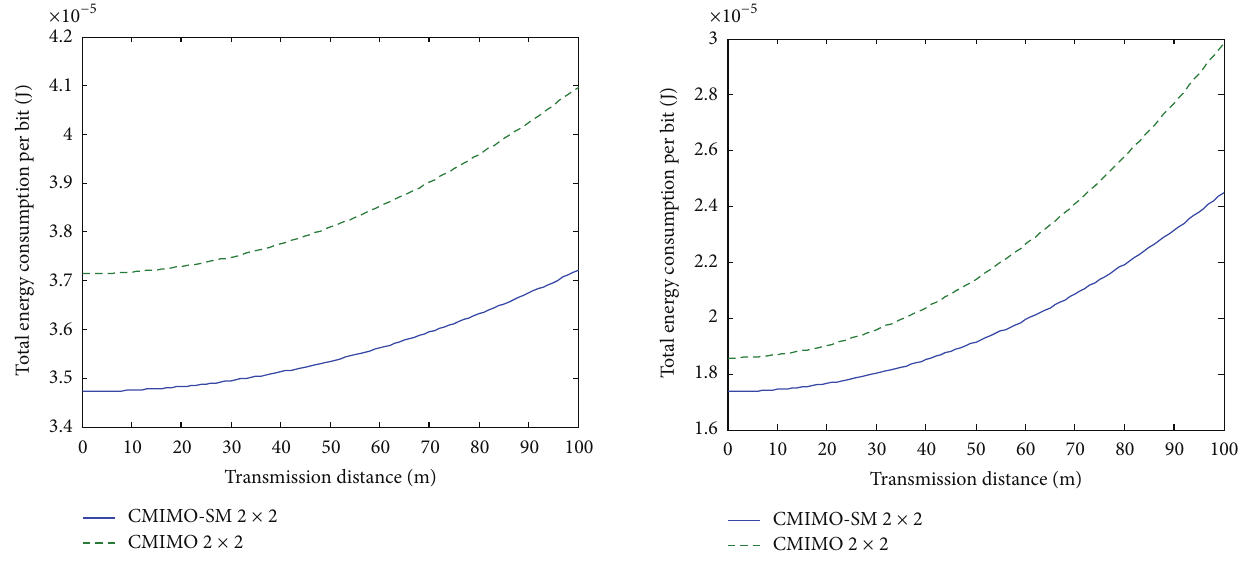
Figure 6: Total energy consumption per bit over d , 2 bits transmis- sion.